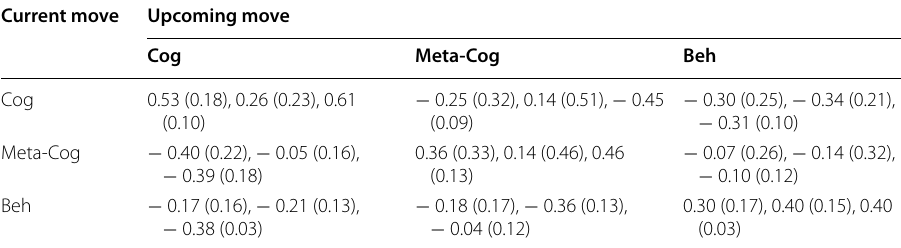
The values are shown as Mean (SD)